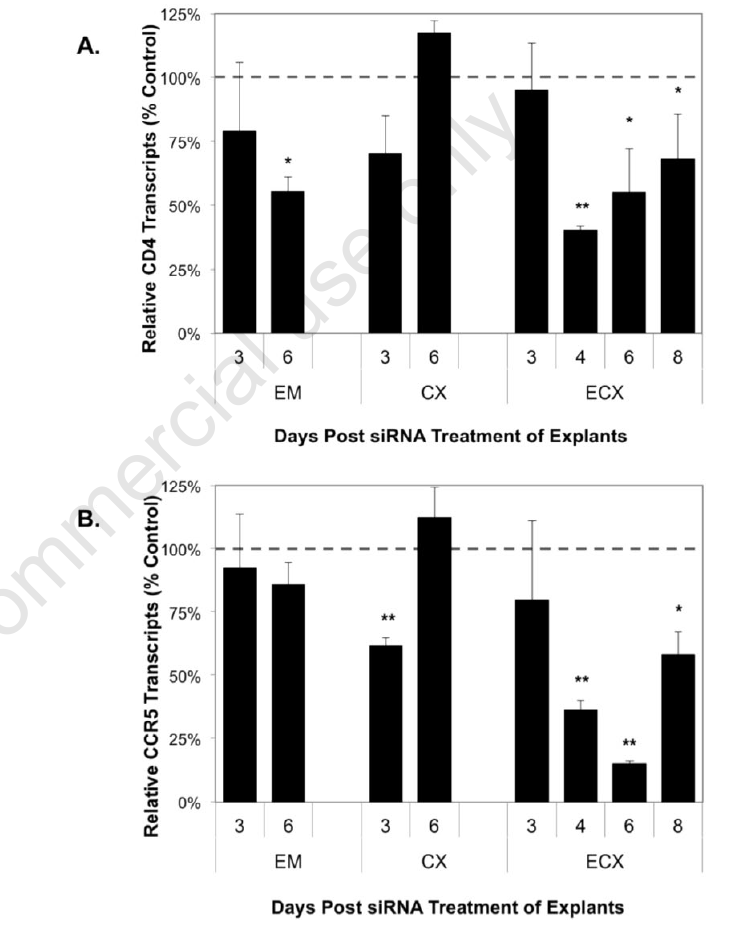
Figure 2. siRNA suppresses both CD4 and CCR5 expression in human female reproduc- tive tract explants. Female reproductive tract tissue explants from the endometrium